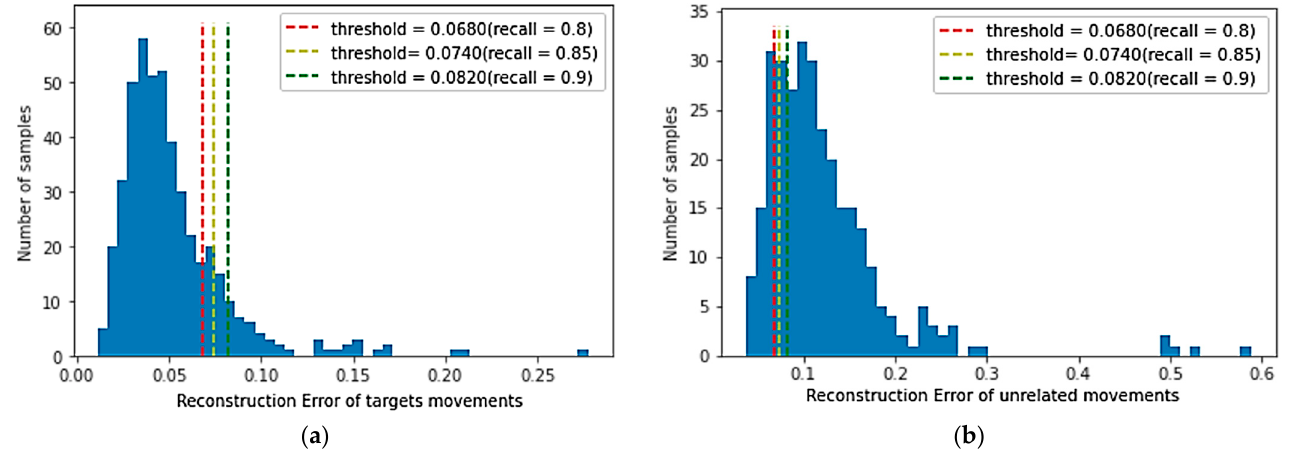
Figure 11. Reconstruction loss distribution achieved by the CNN-AE-S. ( a ) Reconstruction loss distribution in the validation dataset; ( b ) Reconstruction loss distribution of all unrelated movements. Table 2. The comparison with the related